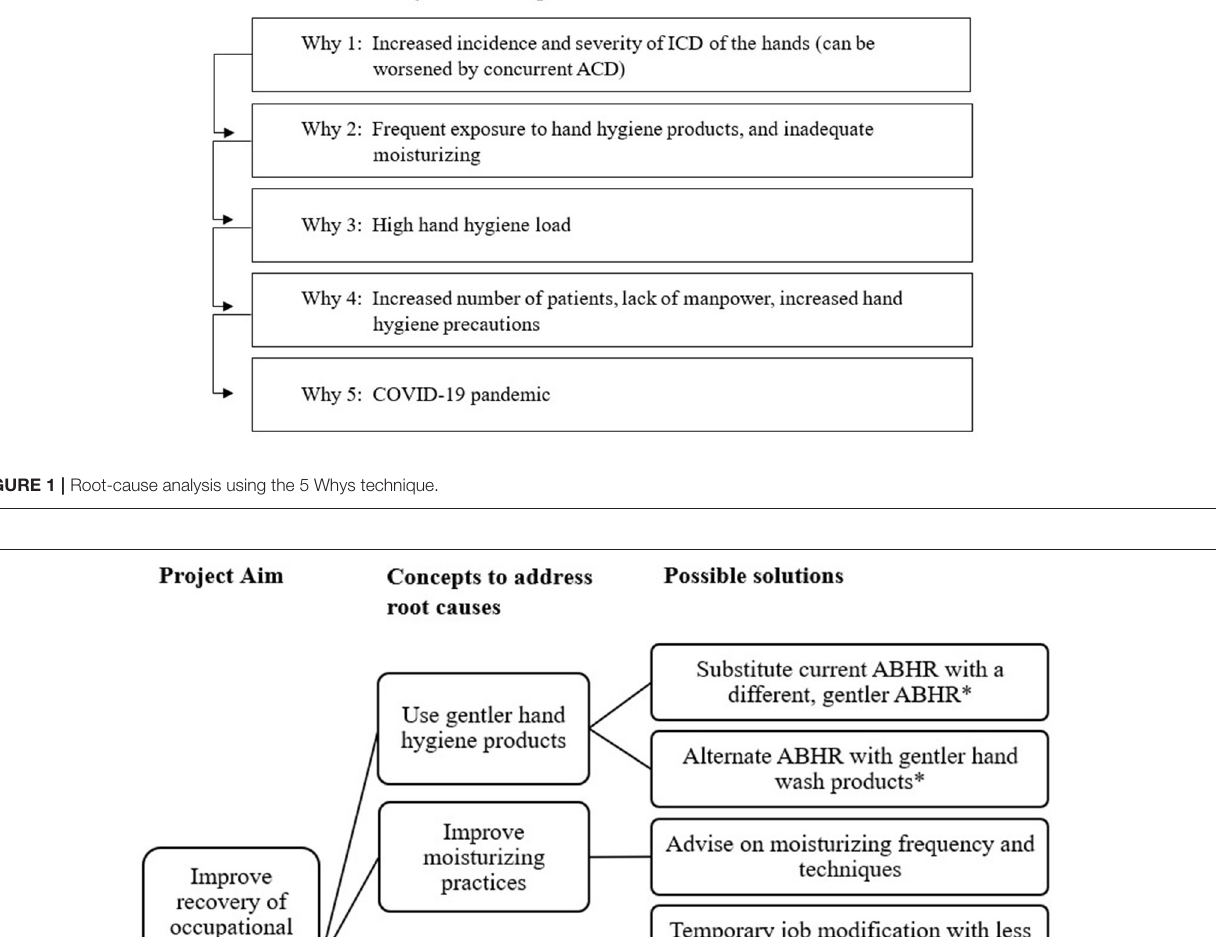
The team subsequently implemented the proposed interventions with the support of key stakeholders such as team supervisors and